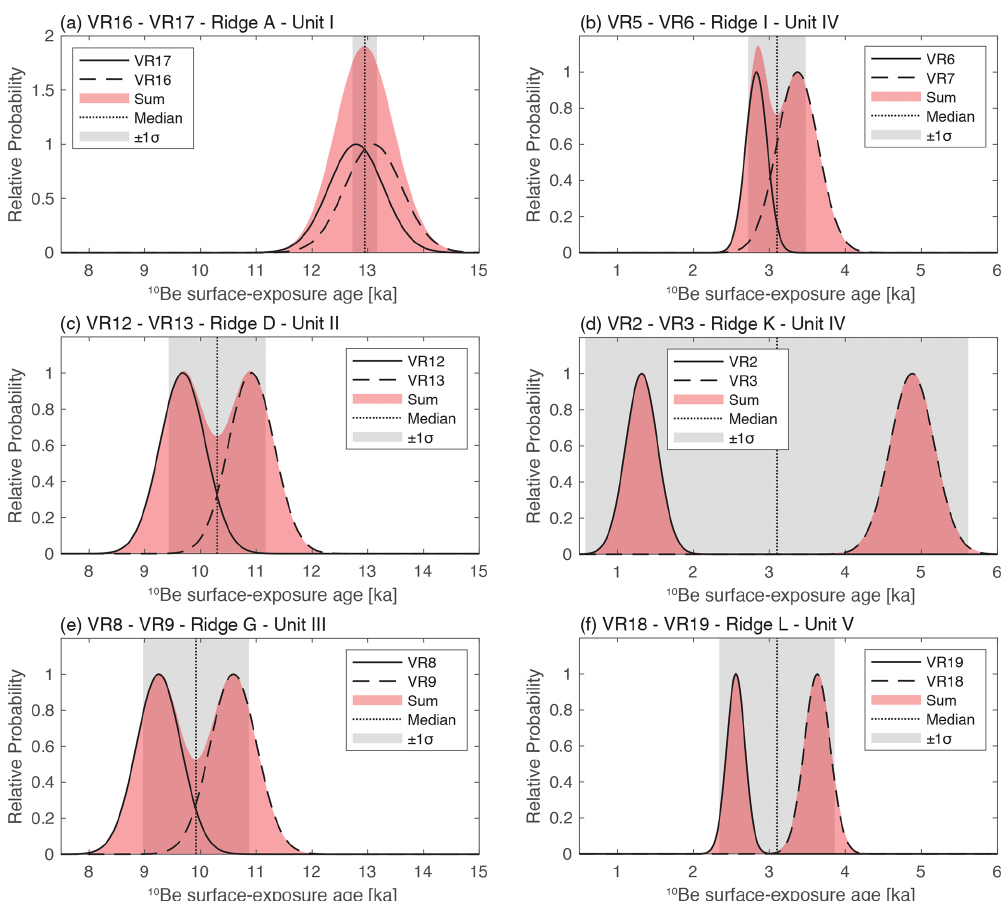
Figure 8. Probability distributions of the individual 10 Be surface-exposure age, sum, and median for each ridge (similar results are shown in Fig. A4 for each